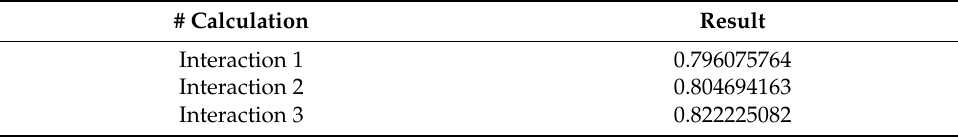
Table 8. Cronbach’s alpha results of three interactions. #